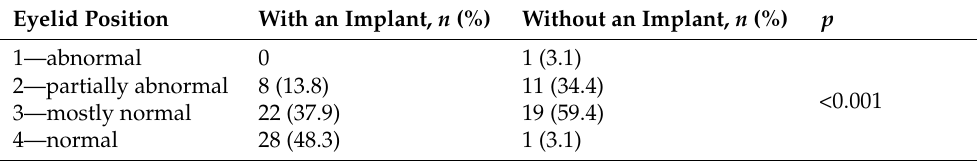
Table 6. Assessment of eyelid position in patients with and without an orbital